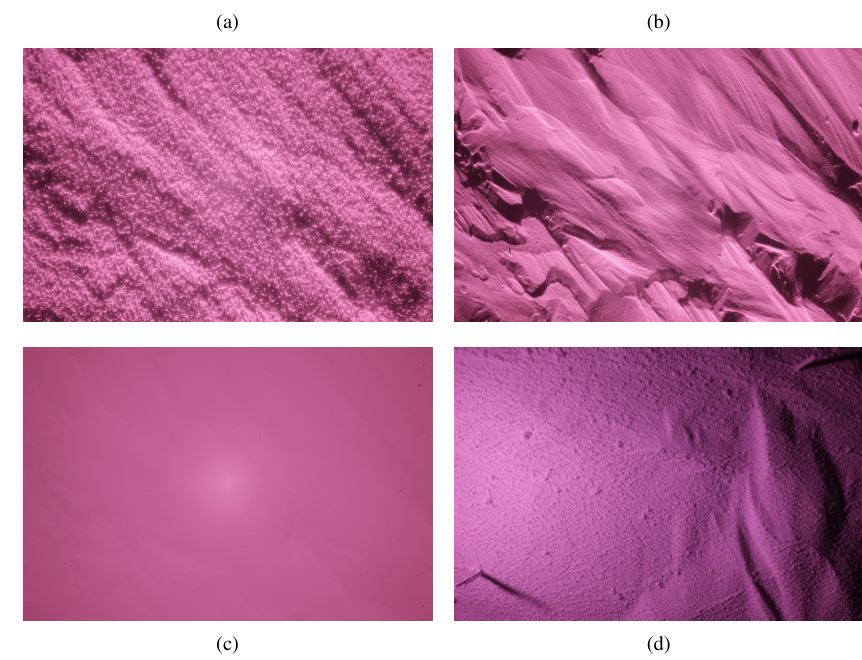
Fig. 4. Near-infrared pictures at Dome C: (a) surface with hoar on 2 January 2010; (b) smooth surface on 25 November 2009; (c) picture under cloudy conditions on 16 December 2009; (d) surface with hoar on 15 June 2011. Fig. 4 : Near-infrared pictures at Dome C: (a) surface with hoar on 2 nd January 2010; (b) smooth surface on 25 th November 2009; (c) picture under cloudy conditions on 16 th December 2009; (d) surface with hoar on 15 th June 2011. 30